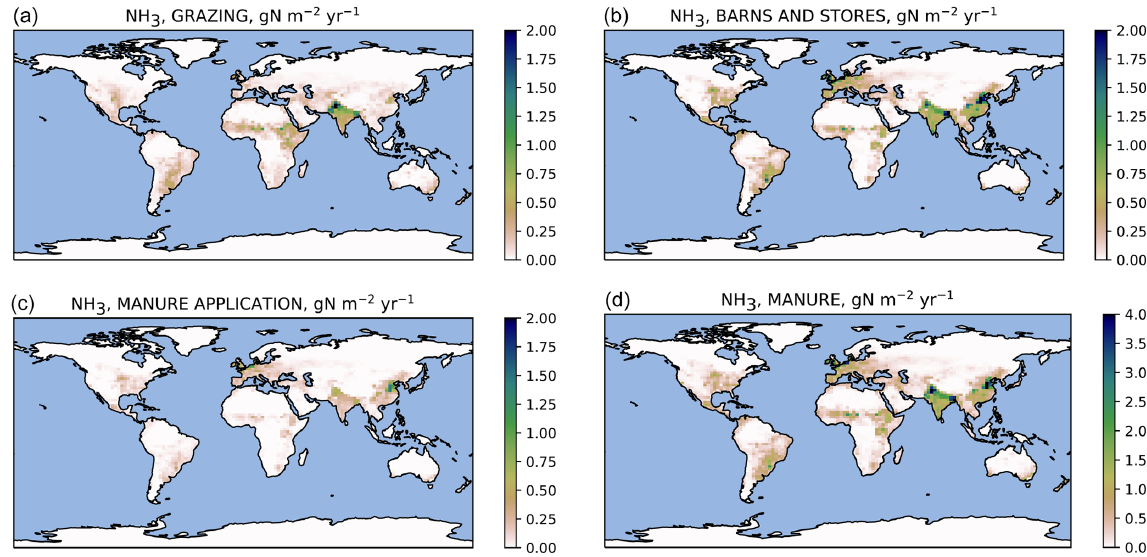
Figure 7. Simulated ammonia emissions (gNm − 2 yr − 1 ) from manure: pastures (a) , barns and storage (b) , manure application (c) , and total from manure (d) averaged over 2010–2015. Note the different color scale for panel (d) .